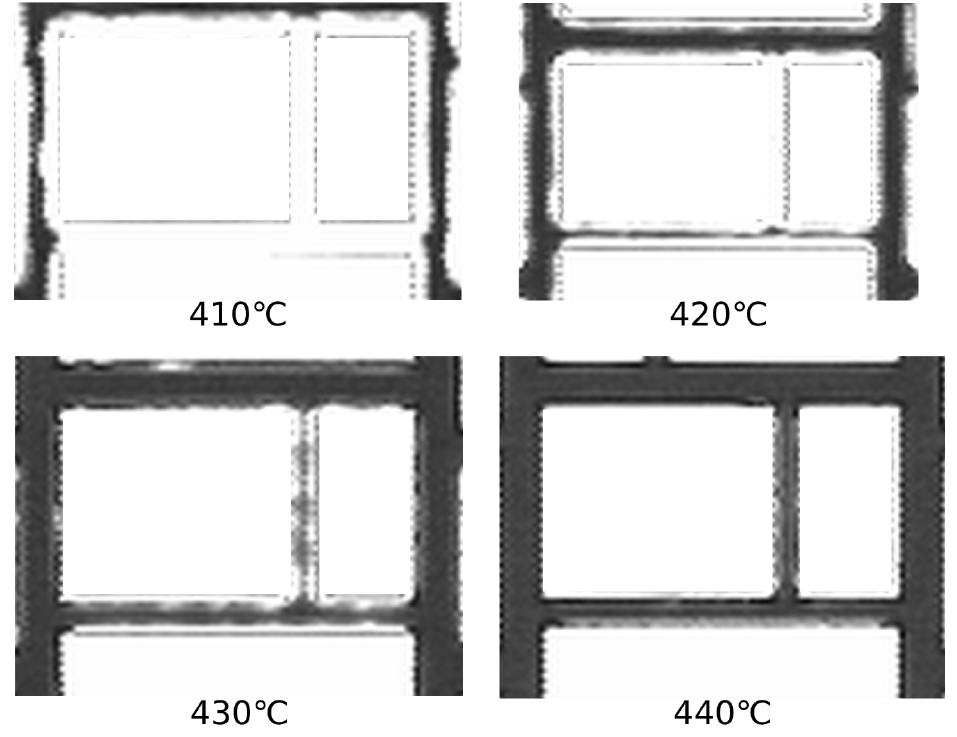
Figure 2. Scanning acoustic microscopy images of glass frit lines at different temperatures during the bonding. Thicker lines correspond to better bonding surfaces.